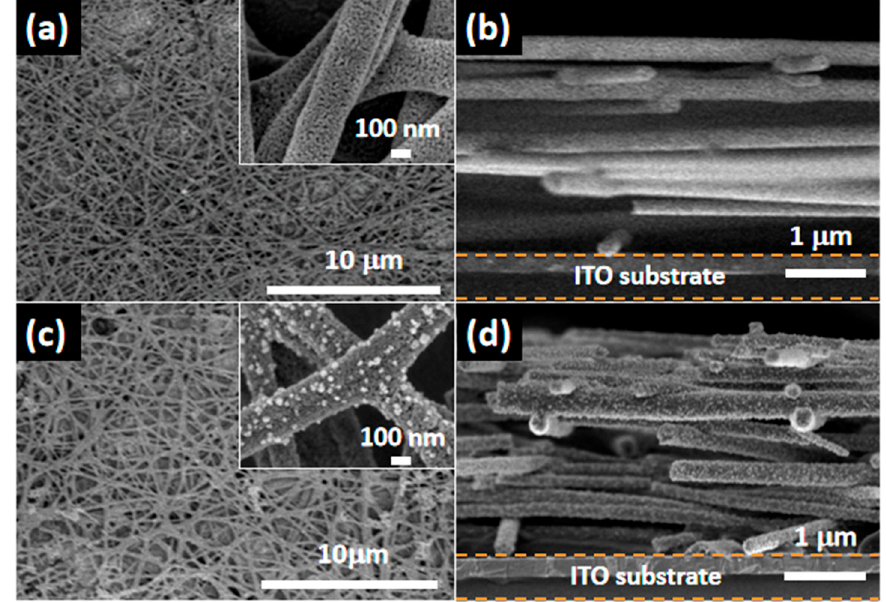
Figure 2. Top-view and cross-section field emission scanning electron microscopy (FE-SEM) images of ( a , b ) pure TiO 2 and ( c , d ) 15-Au / TiO 2 NFs on indium tin oxide (ITO) substrates. Insets of ( a , c ) are enlarged FE-SEM